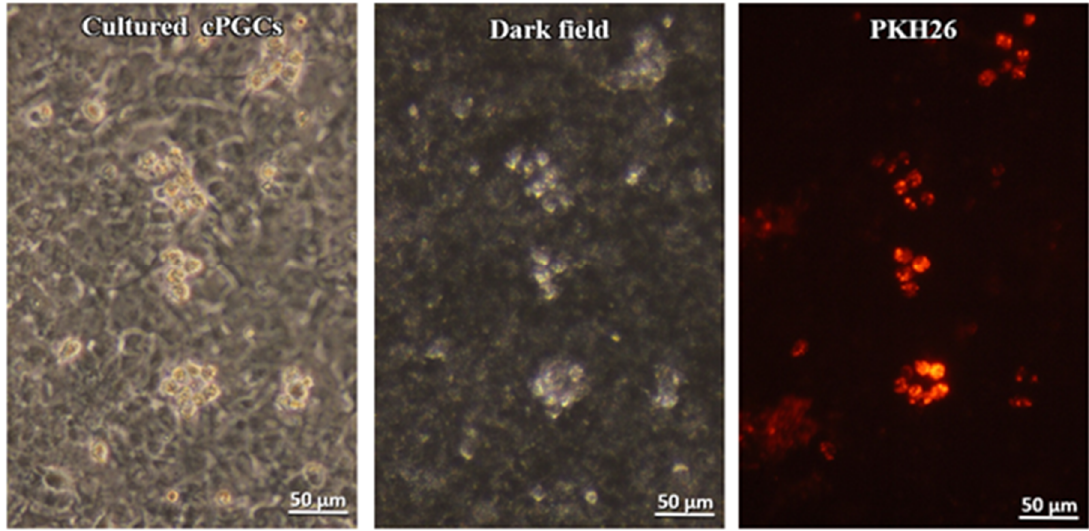
Figure 3. The cPGCs cultured for 7 days observed under an inverted phase-contrast microscope and darkfield illumination (P.434242 patent application number). The cells were stained after 7 days of culture using PKH26 fluorescent dye. Magnification of the objective 40× (Leica DMI8).